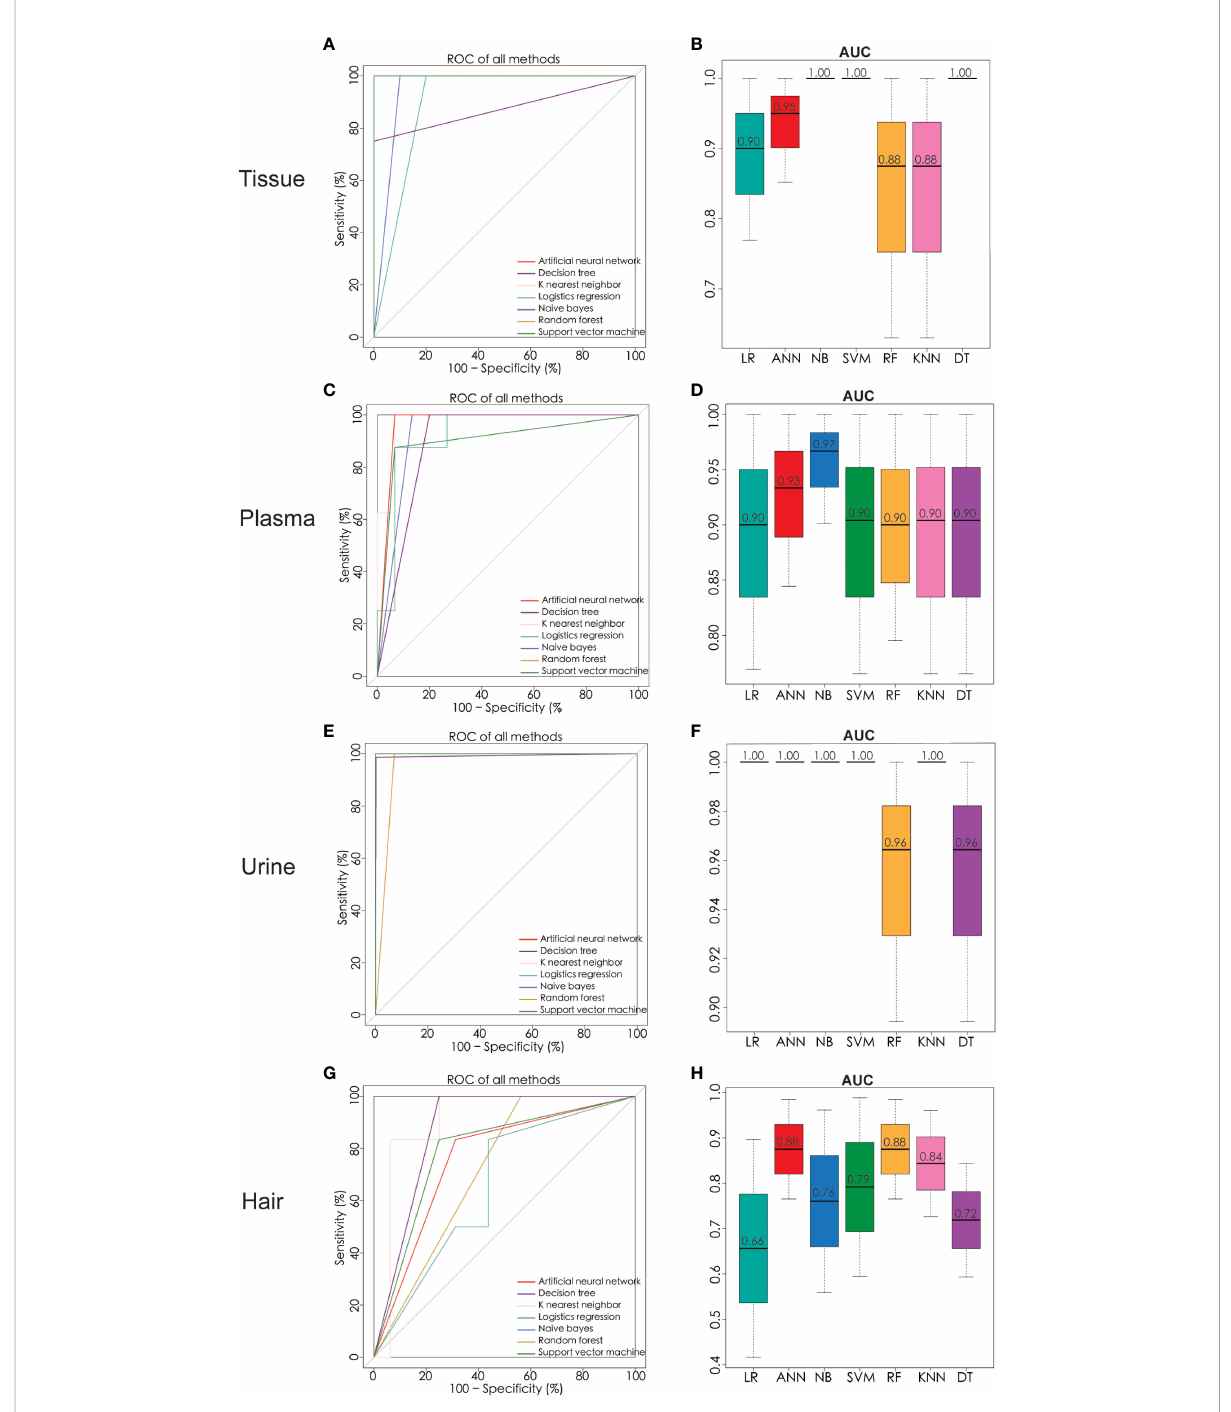
FIGURE 4 Signi fi cant metabolites were nominated and ROC analysis by seven machine learning models of ANN, DT, KNN, LR, NB, RF, and SVM. ROC curve analysis and corresponding AUC (median with 95% con fi dence interval) of every model on tissue (A, B) , plasma (C, D) , urine (E, F) , and hair (G, H) . ROC receiver operating characteristic, AUC area under the ROC curve, ANN arti fi cial neural network, DT decision tree, KNN K nearest neighbor, LR logistics regression, NB naïve bayes, RF random forest, SVM support vector machine. Number of tissue sample in control group (n = 14), BOT group (n = 16), and OC group (n = 16). Number of plasma sample in control group (n = 13), BOT group (n = 16), and OC group (n = 17). Number of urine sample in control group (n = 13), BOT group (n = 15), and OC group (n = 17). Number of hair sample in control group (n = 13), BOT group (n = 16), and OC group (n =